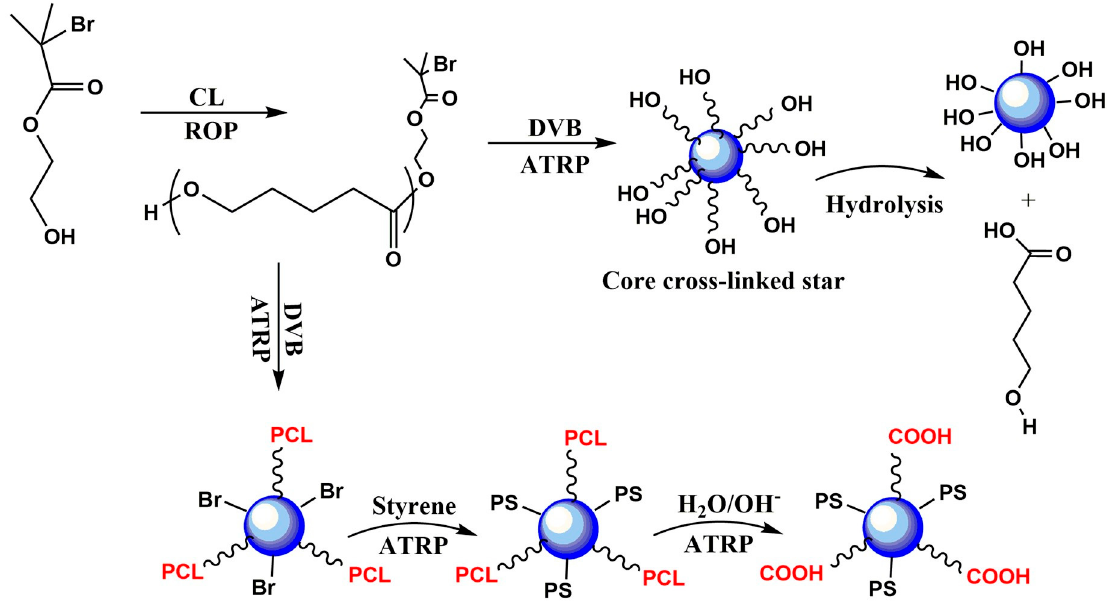
Figure 4. The potential of multi-arm polymers to form new types of core cross-linked stars and their eventual hydrolysis.